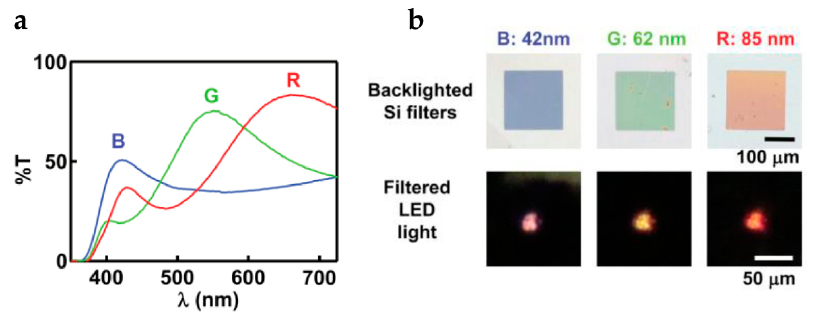
Figure 2. ( a ) Transmission spectra of different bioresorbable optical filters based on single-crystalline silicon nanomembranes. ( b ) Optical images of the bioresorbable optical filters and the filtered light from the integration of filters and LEDs. ( a , b ) Reproduced with permission from [35].